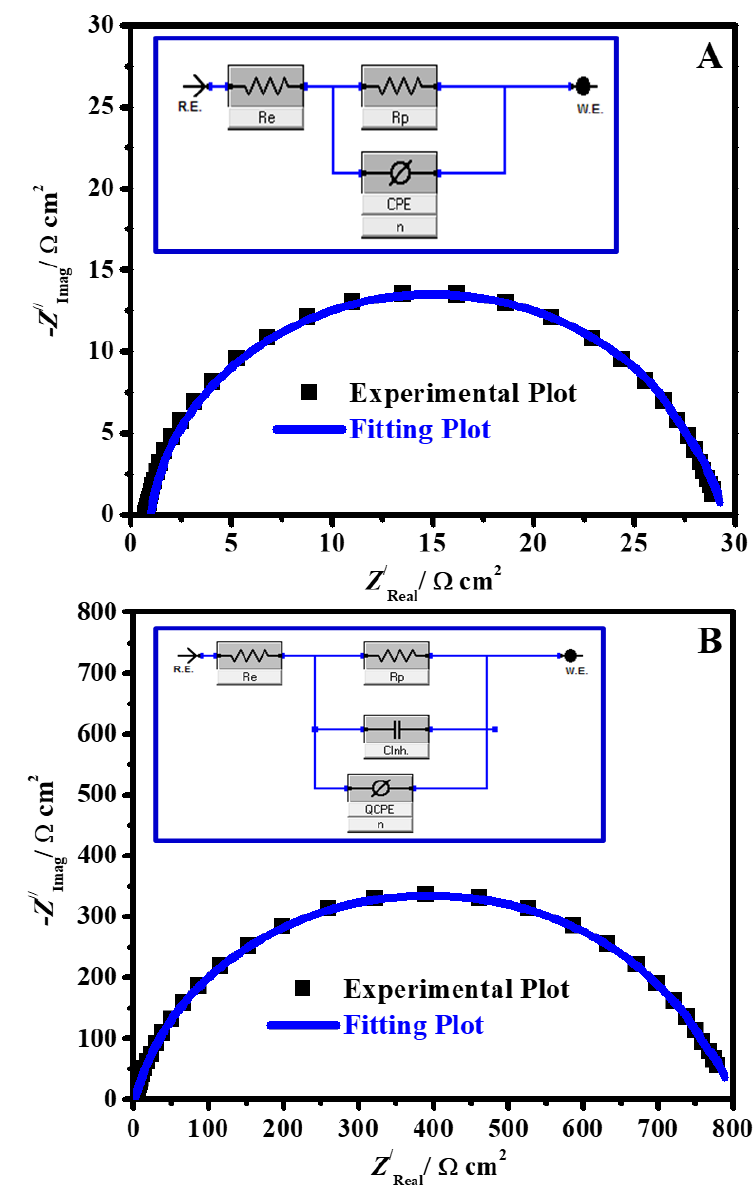
Figure 9. Experimental and fitted Nyquist results of C-steel in an uninhibited system ( A ) and an inhibited system ( B ) Inset equivalent circuits model for the